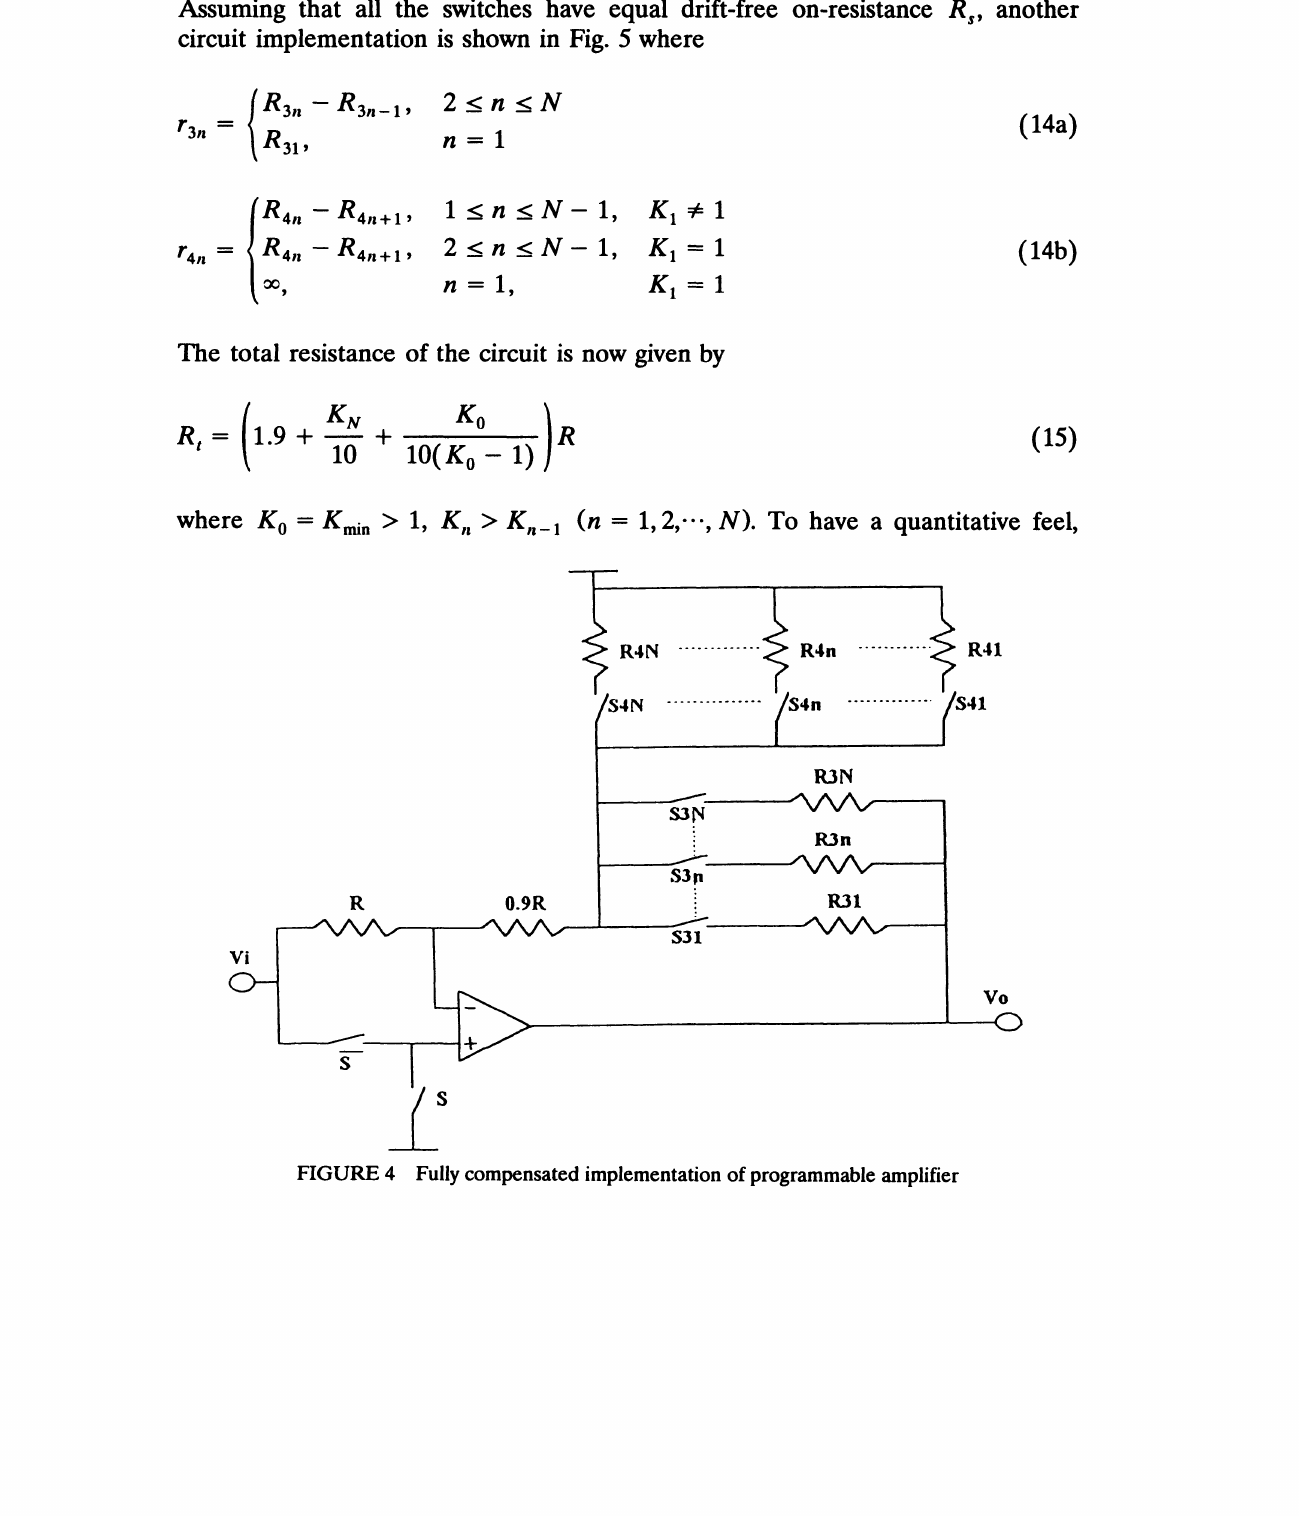
Fully compensated implementation of programmable amplifier